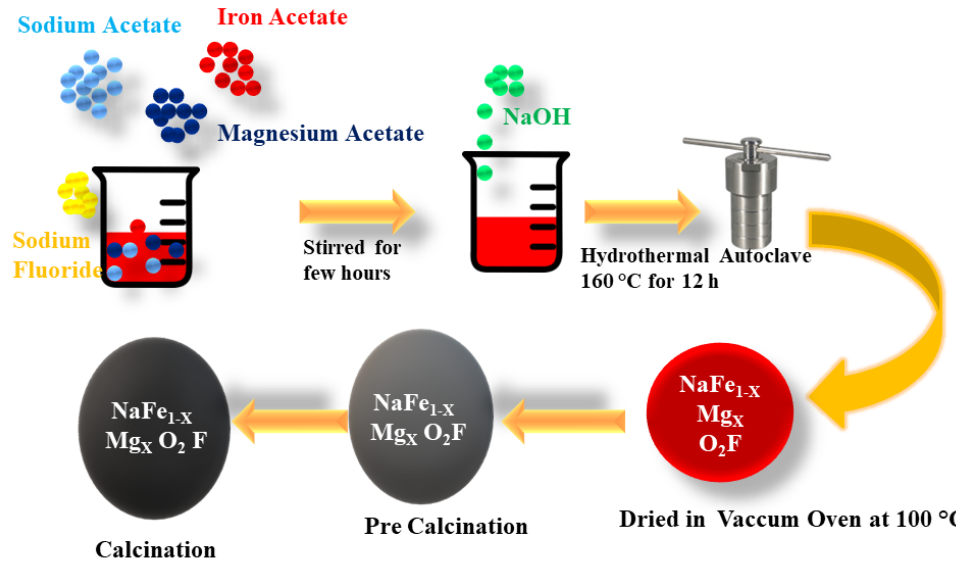
Figure 1. The Schematic Preparation of O3-NaFe 1-x Mg x O 2 F through the hydrothermal method.